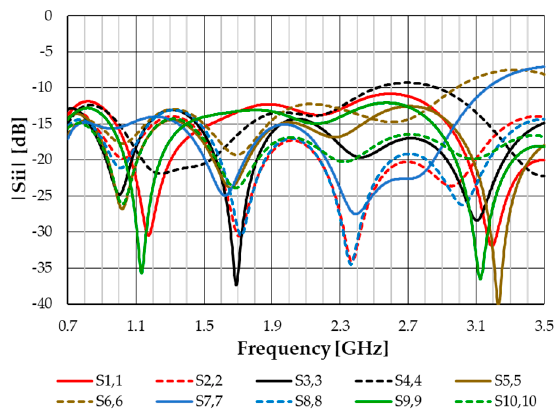
Figure 23. Simulated |S|-parameters’ results of the antenna system.